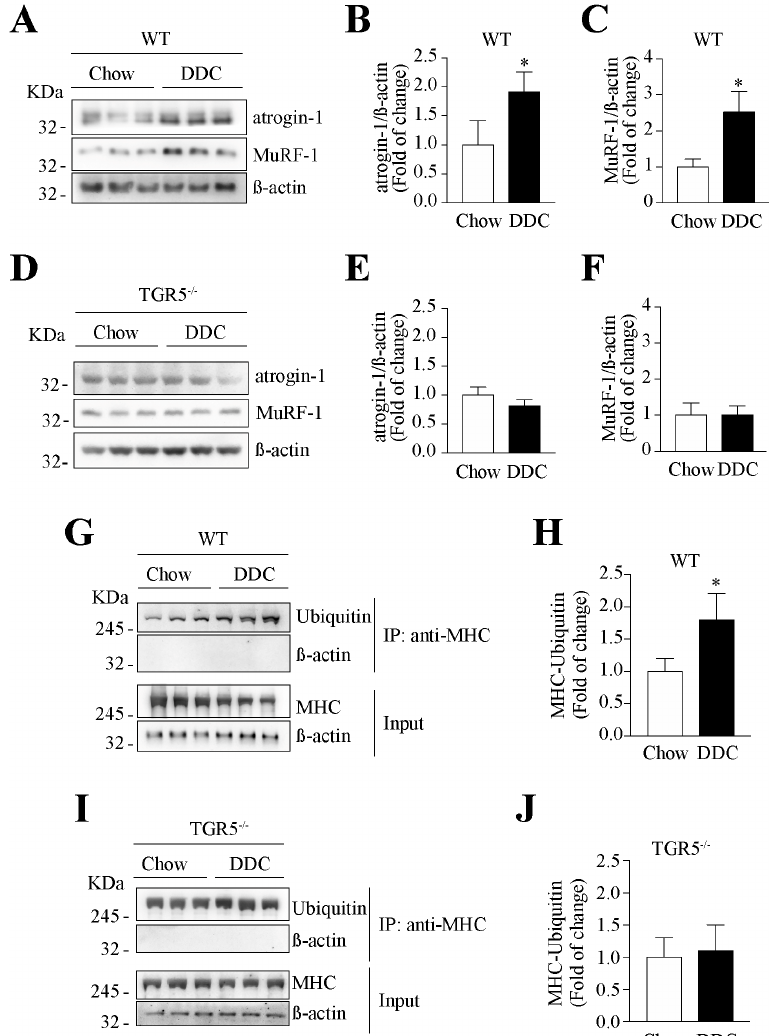
− / − fed with the DDC diet. In the TA muscle from TGR5 mice, there is no di ff erence in atrogin-1 (Figure 7E, chow = 1.00 ± 0.08 vs. DDC = 0.81 ± 0.09) and MuRF-1 (Figure 7F, chow = 1.00 ± 0.19 vs. DDC = 1.01 ± 0.15) protein expression between the chow and DDC diets. Int. J. Mol. Sci. 2020 , 21 , x FOR PEER REVIEW